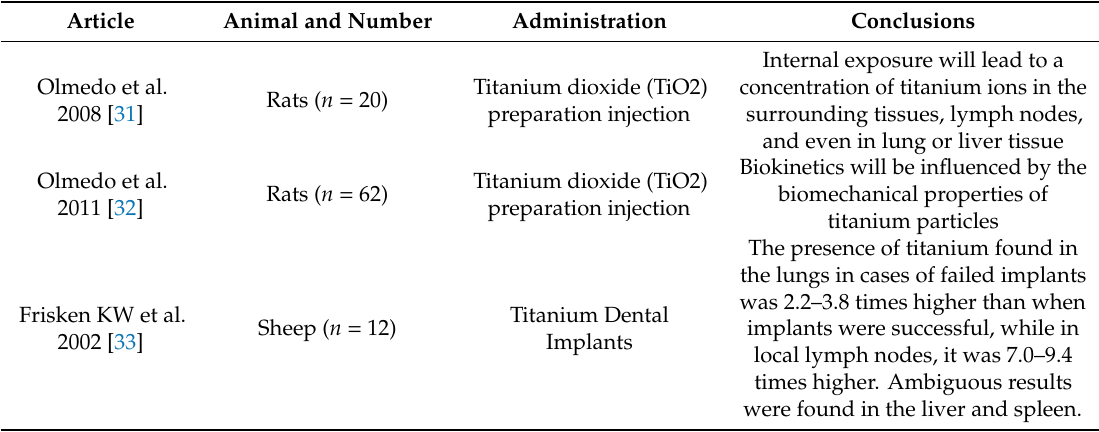
Table 2. In-vivo